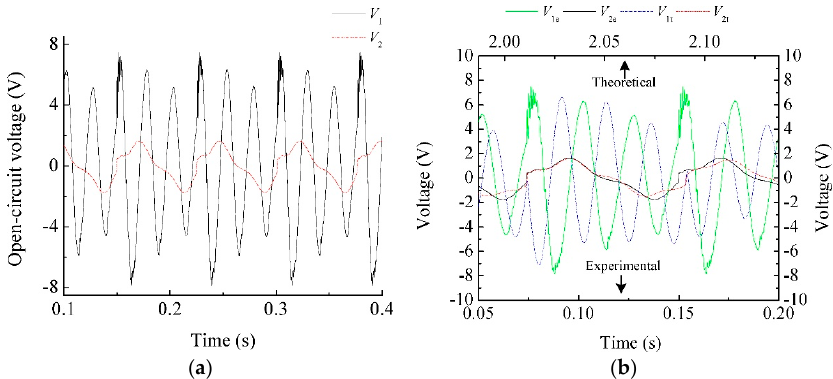
Figure 7. ( a ) The measured open-circuit voltages from the PEH and EMEH subsystems, and ( b ) Comparison between theoretical and experimental open-circuit voltage waveforms.